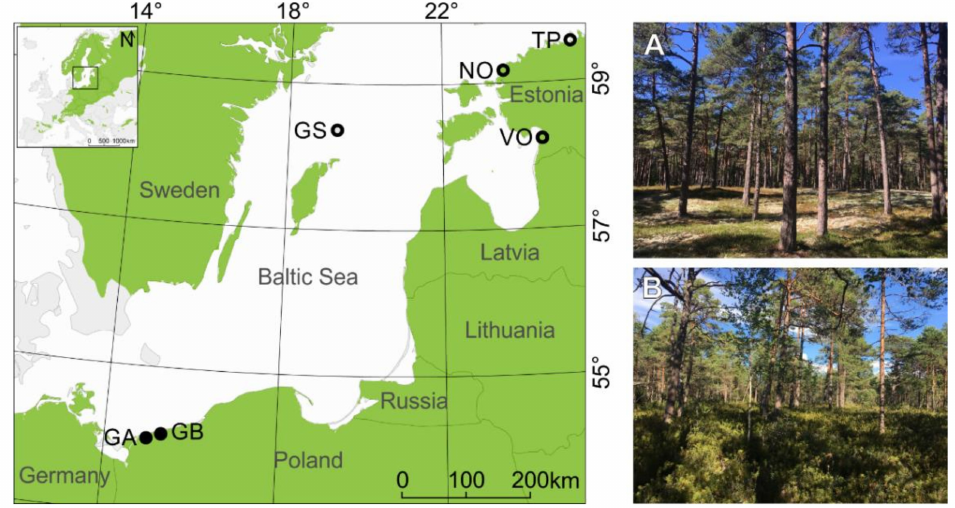
Figure 1. The map shows the location of sampling sites around the south Baltic Sea. Black dots indicate sites located in the southern subregion, while black circles indicate sites located in the northern subregion (see Figure 2 in [55]). The inset map shows the location of research area, and